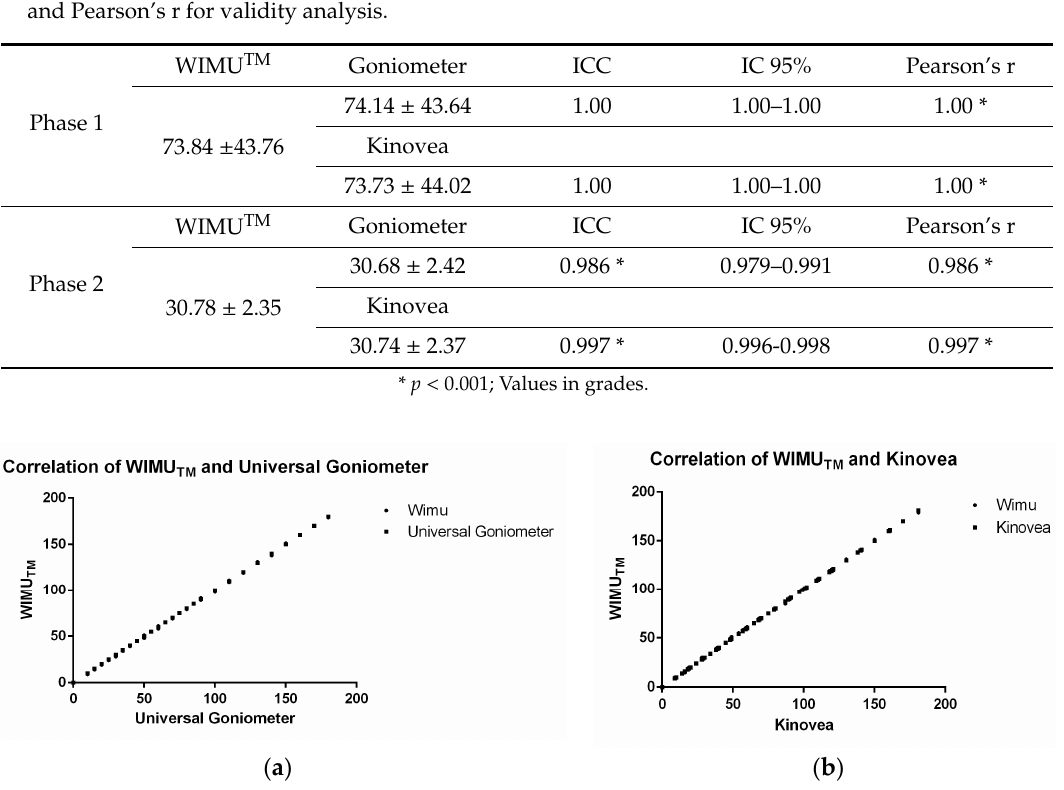
Table 1. Descriptive statistics and validity analysis based on intraclass correlation coe ffi cients (ICC) and Pearson’s r for validity analysis.